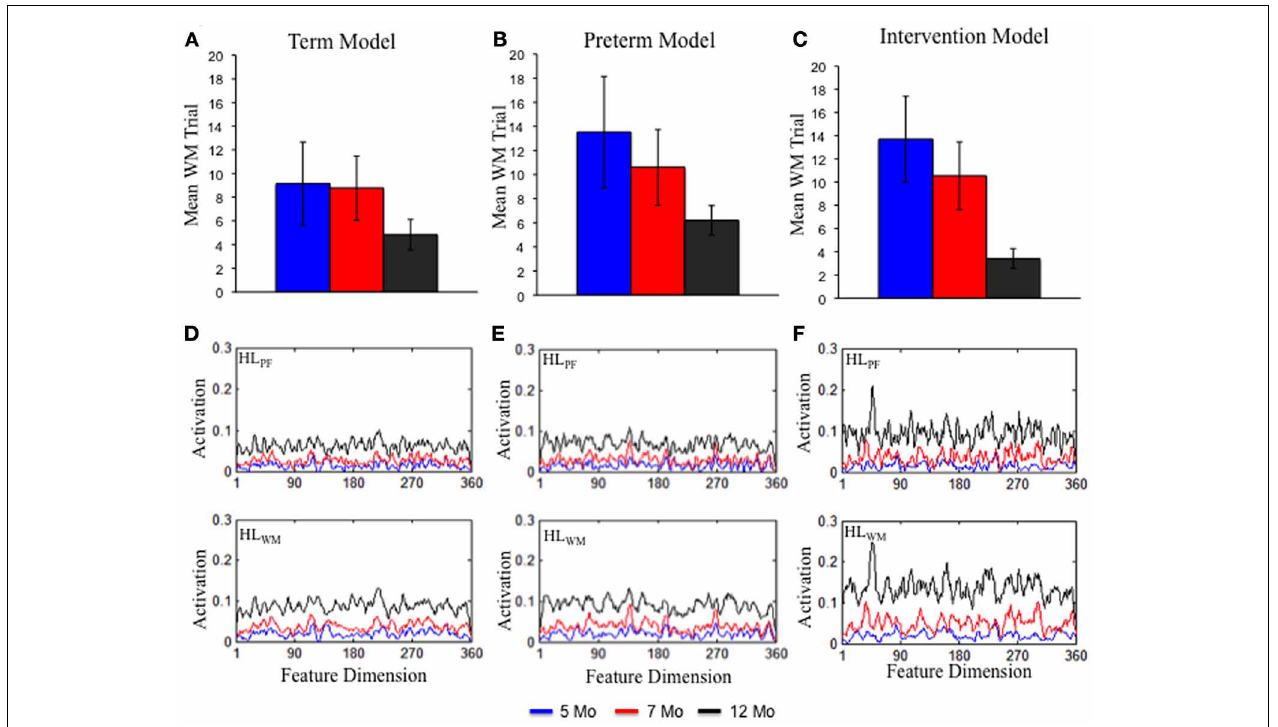
FIGURE 5 | The top shows the rate at which DNF model formed a stable WM peak for the term (A), preterm (B), and intervention (C) models at 5 (blue), 7 (red), and 12 (black) months of age. Over development, all models formed a stable WM peak more quickly. The rate of WM peak formation was delayed for the preterm model but